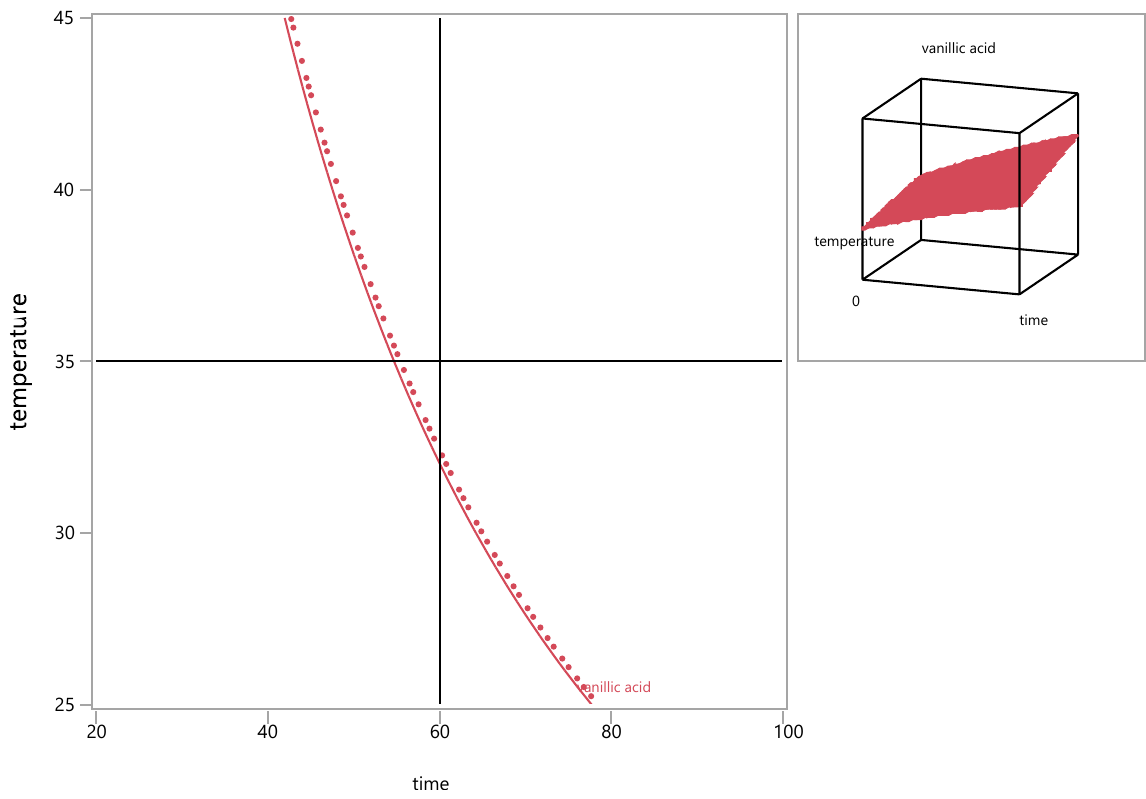
) 25±0.1°C; (•) 35±0.1°C and ( ▪